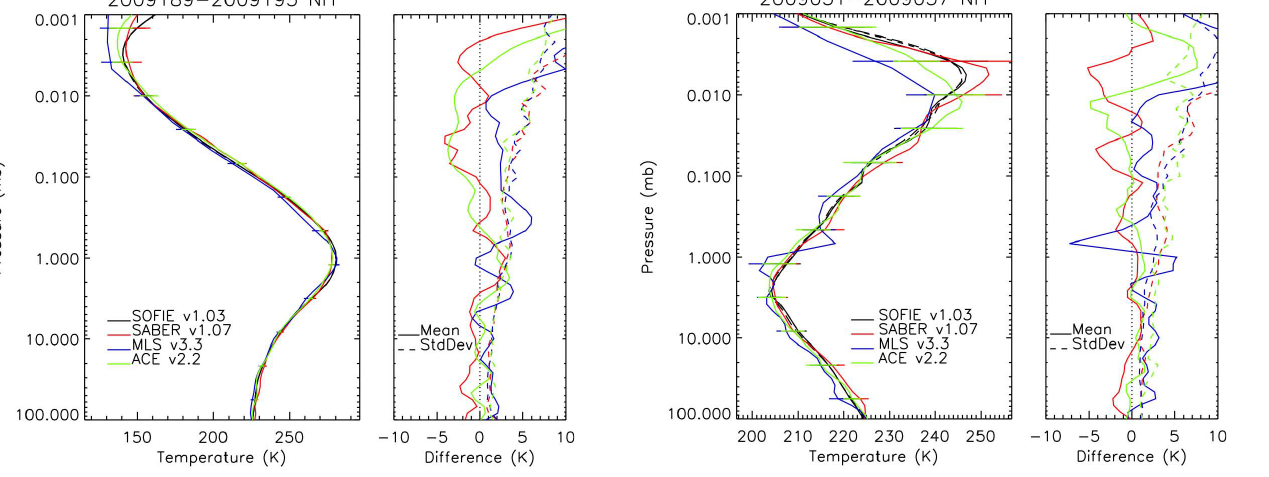
Fig. 30. Comparison between mean SOFIE (black), SABER (red), ACE (green), and MLS (blue) profiles for coincident Northern Hemisphere (NH) data for the period 8–14 July 2009, left-hand panel shows the mean profiles, right-hand panel shows the mean difference and difference standard deviation profiles (SOFIE – each of the others).